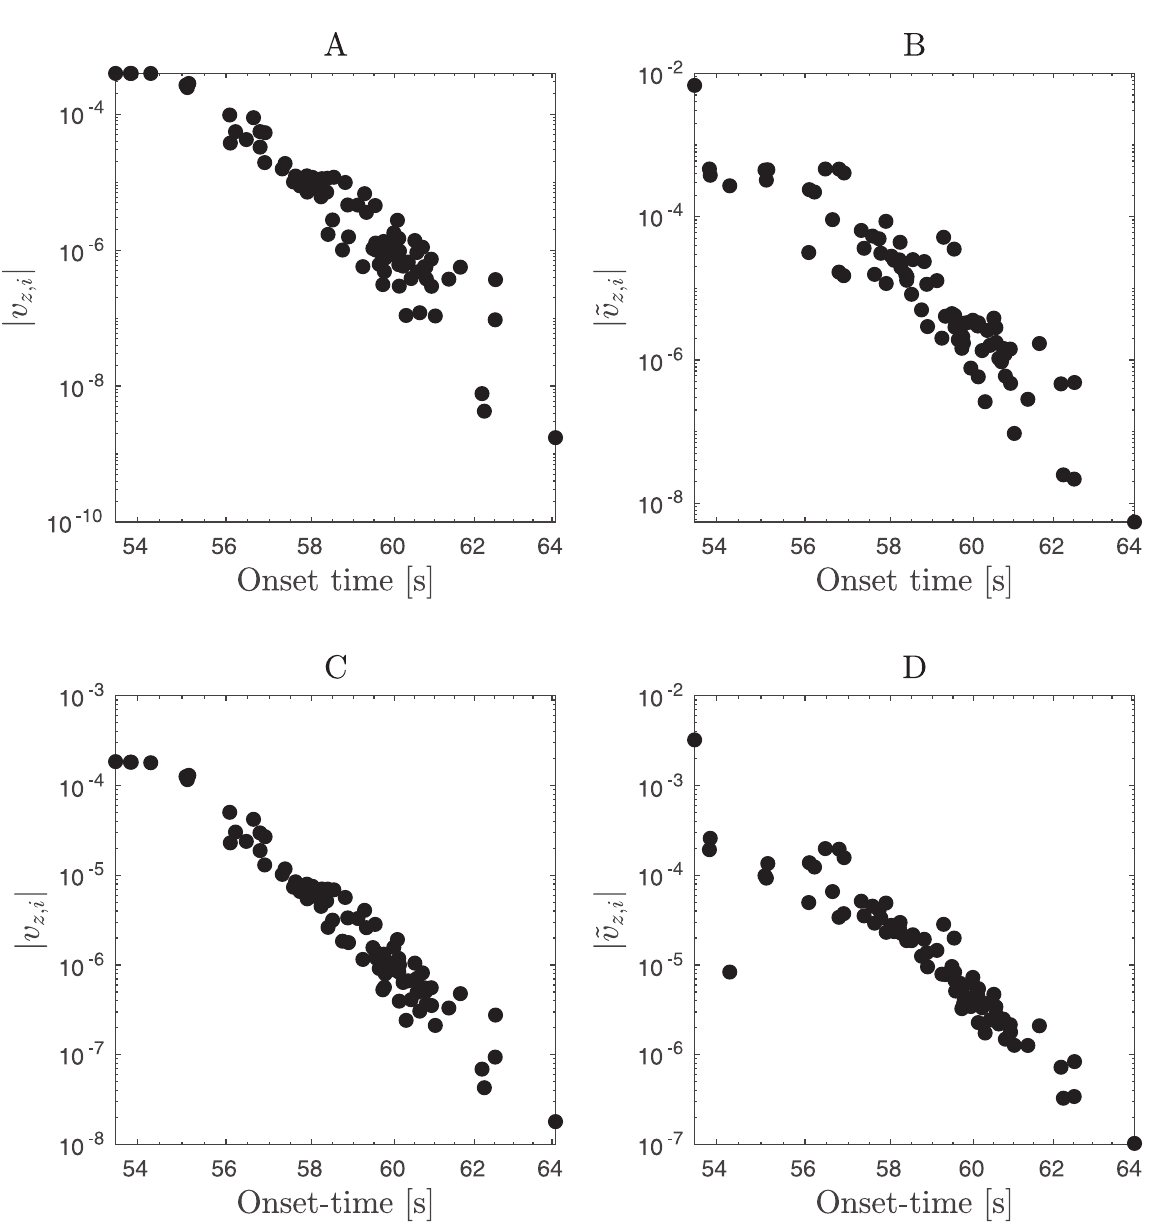
Fig 4. Relationship between the leading eigenvector of the Jacobian matrix and the temporal order of seizure spread (seizure onset times) across different nodes. The magnitude of the components of the leading eigenvector of the Jacobian matrix from the epileptor network are denoted by | v |, with z , i indicating that the component relates to the permittivity variable z in the i th node. Similarly for j ~ v z , i leading eigenvector computed from the Jacobian matrix where the active EZ node is replaced by a constant input to nodes connected to it (see Fig 3). (A,B) panels are based on the 2D-reduced epileptor network model while (C,D) panels are based on the original epileptor network model. Note that these magnitudes predict roughly wells the temporal order of seizure spread across the network, in particular the magnitudes based on the Jacobian matrix of the network that includes the active EZ node. The examples were obtained from a single stochastic realization for patient P1, node 64 as the active EZ ( x 0 = − 1.6), surrounding-node excitability x 0 = − 2.13, global connectivity strength w = 1.1, and noise level at σ = 0.05. See Fig 5 for a statistical summary for different patient-specific connectivity matrices, different active EZ locations, noise levels and stochastic realizations.